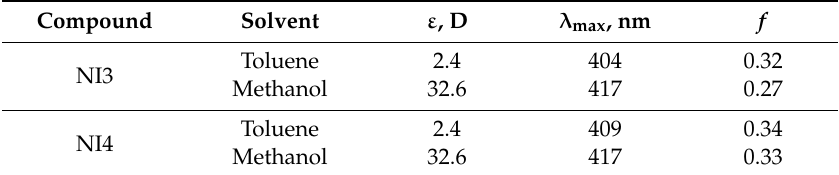
Table 3. Time-Dependent Density Functional Theory—p.3 (TDDFT)/PBE0 calculated absorption maximum ( λ max ) and oscillator strength for compounds NI3 and NI4 in selected solvents with different polarities.